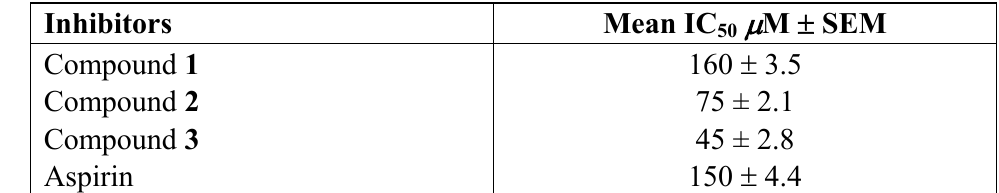
Table 4. The effects of compounds 1-3 on arachidonic acid (1.73 mM) induced platelet